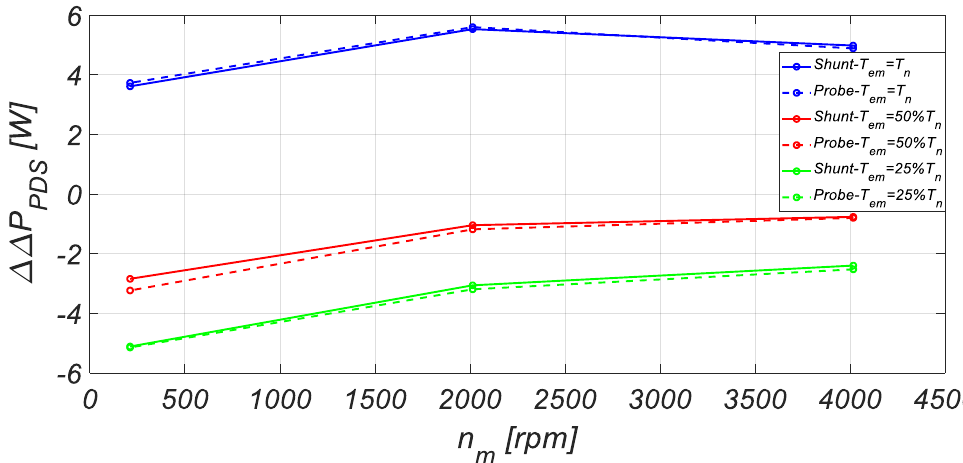
Figure 7. ∆∆ P PDS as a function of the reference speed for a variation of d-axis current from I d = 0 A to I d = −1 A and for each of the proposed working condition.